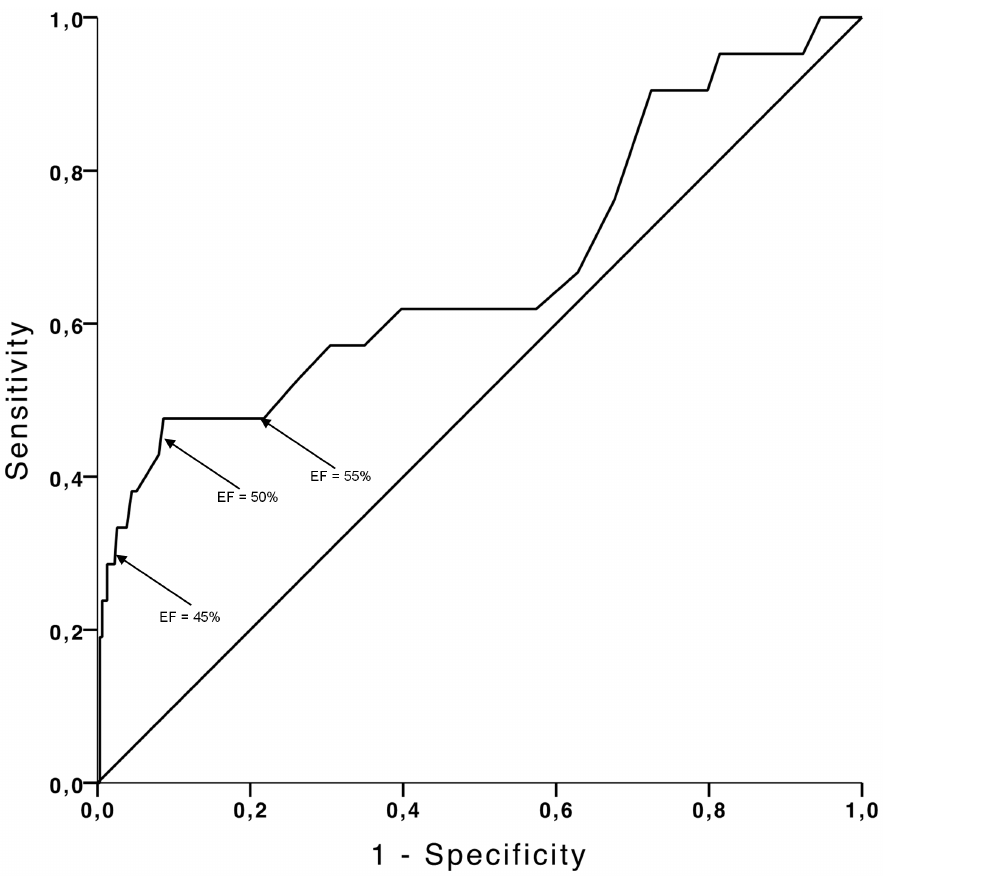
Figure 2. Received operating characteristic (ROC) curve for detection of CHF by LVEF in patients treated with cardiotoxic chemotherapy. Area under the curve is 0.67 (CI 0.53–0.81, p=0.008). The arrows indicate selected cut-off concentrations for LVEF. A LVEF of 50% correspond to a sensitivity of 48% and a specificity of 91%. The diagnostic performance of LVEF at 45% and 55% showed a sensitivity of 38% and 45% and specificity of 97% and 78%, respectively.